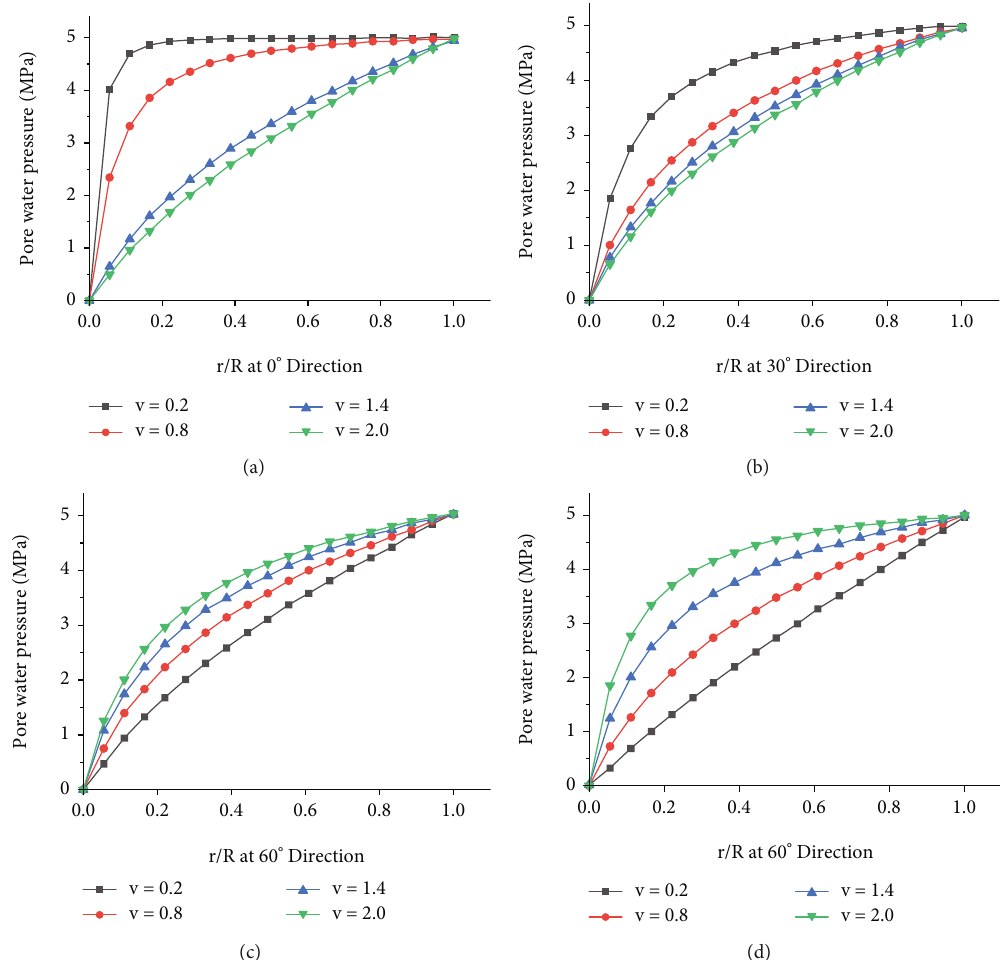
Figure 5: Di ff erent ν pore water pressure distribution of surrounding rock in di ff erent directions under the condition of value.